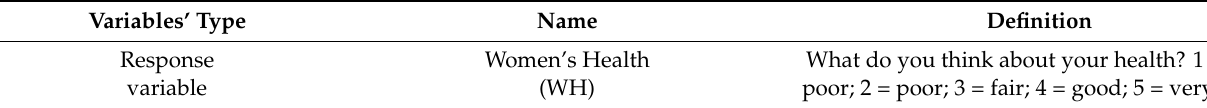
Table 1. Variable’s selection and